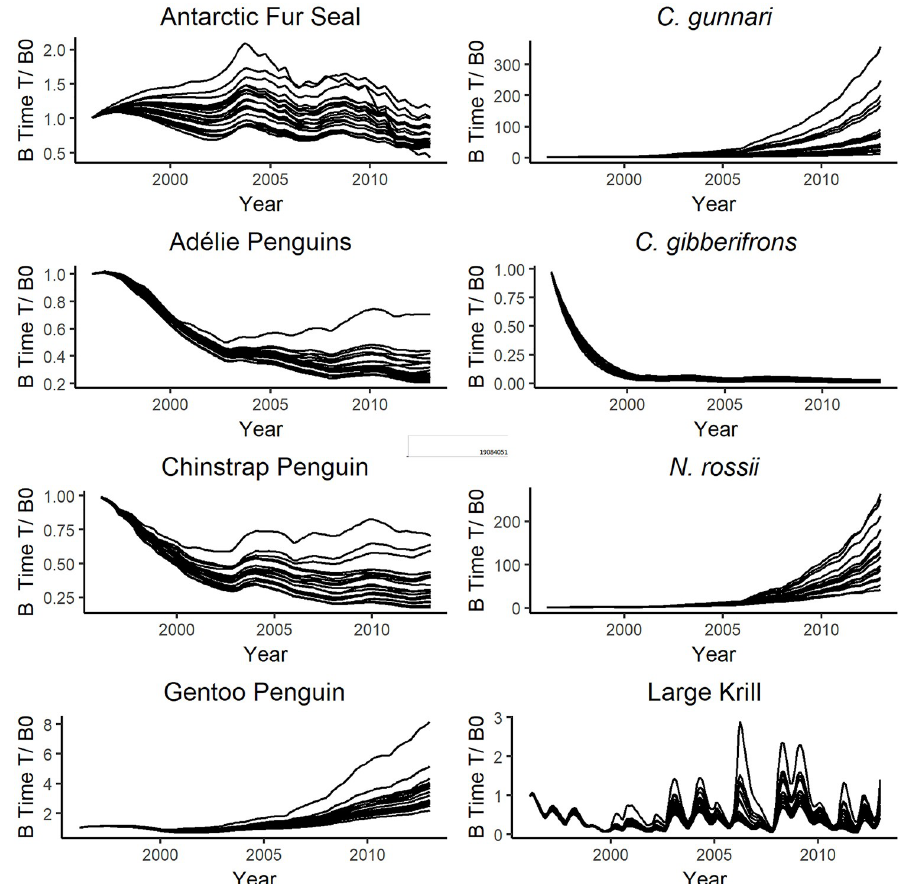
Fig 9. Results of twenty randomly selected Monte Carlo trials. Each line represents the relative biomass trajectory of that species over the course of a single trial. Note that the starting value for all species is one, and model results is relative to that value. Also Note that the y-axis scales for N . rossii and C . gunnari are two to three orders of magnitude larger than the scales for the other species, indicating much higher sensitivity and uncertainty for these two